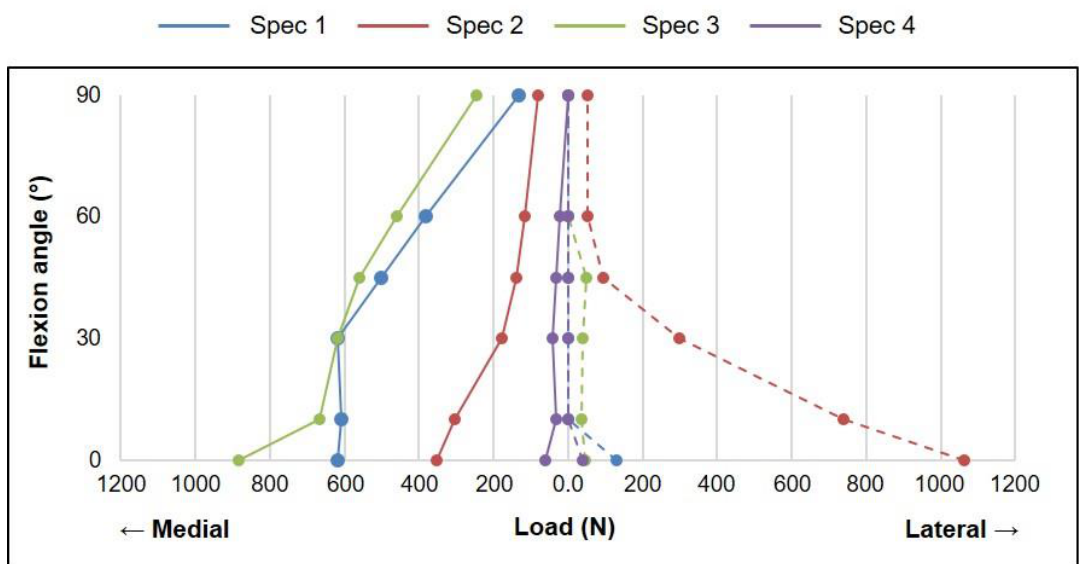
Figure 1. Intraoperative intra-articular loads in the medial (solid) and lateral (dashed) compartments of each specimen reduced with increasing knee flexion.